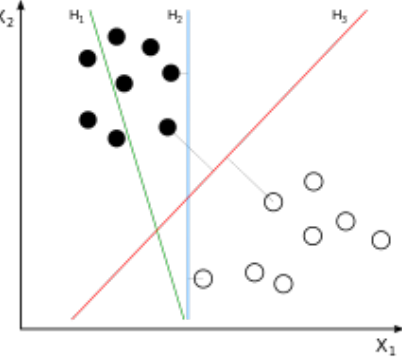
Figure 1. Principle of the support vector machine. A line (or hyperplane) H 1 does not separate black and white circles while hyperplanes H 2 and H 3 separate the two groups. Here, the distance between the two groups is maximal for H 3 and the support vector machine creates such a hyperplane. Image provided by Wikipedia.